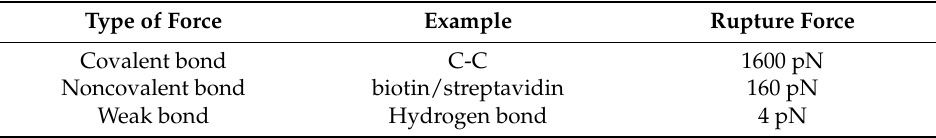
Table 1. Selected forces involved at the biological level.